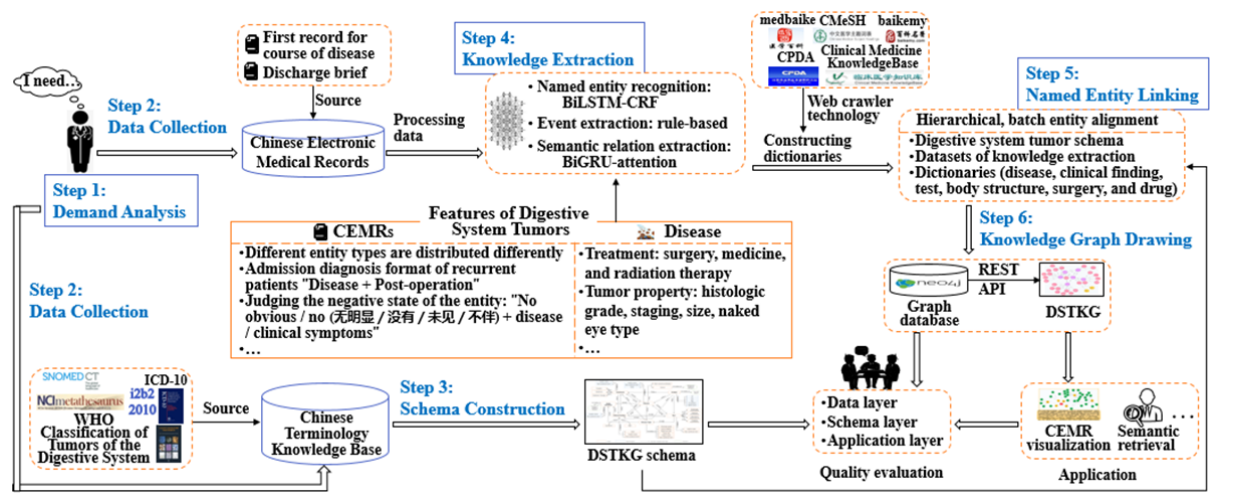
Figure 1. Construction framework of a digestive system tumor knowledge graph (DSTKG) based on Chinese electronic medical records